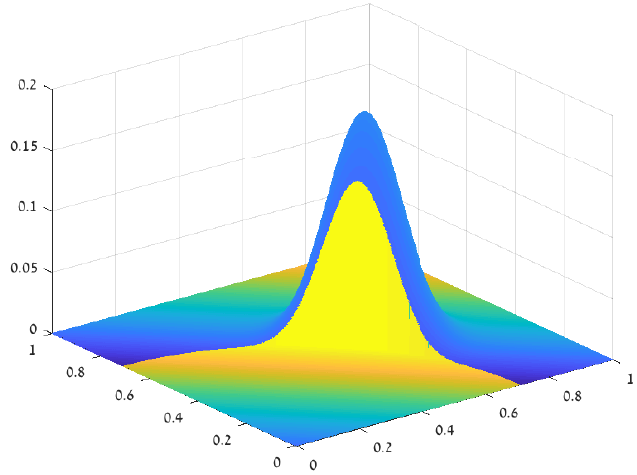
Figure 15. One of the tensor product B-splines used for the approximation of f , chopped off by the singularity curve.